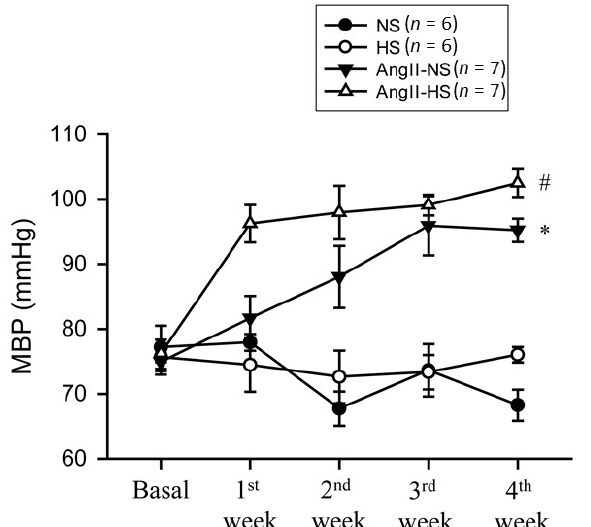
Figure 2. MBP responses to chronic AngII (25 ng/min) infusion in mice given NS (NS; 0.3% NaCl) and HS (HS; 4% NaCl) containing diets; * : P < 0.05 vs. NS; #: P < 0.05 vs.